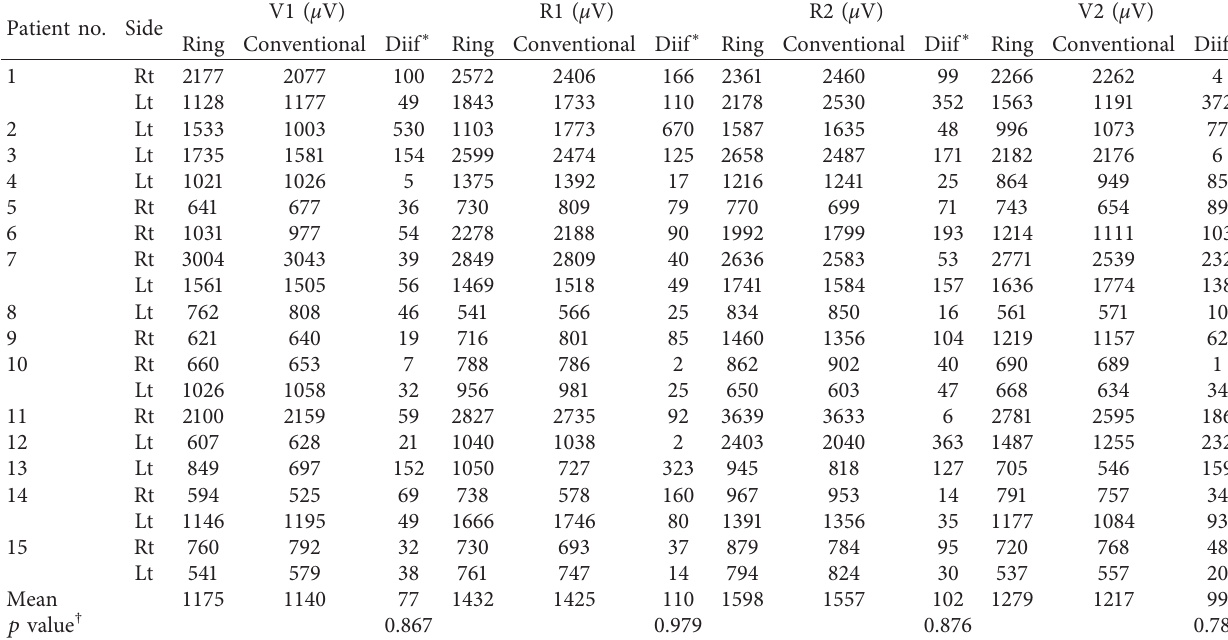
Table 2: EMG amplitude profiles of recurrent laryngeal nerve and vagus nerve stimulated by the attachable ring stimulator and conventional stimulator. Patient no.